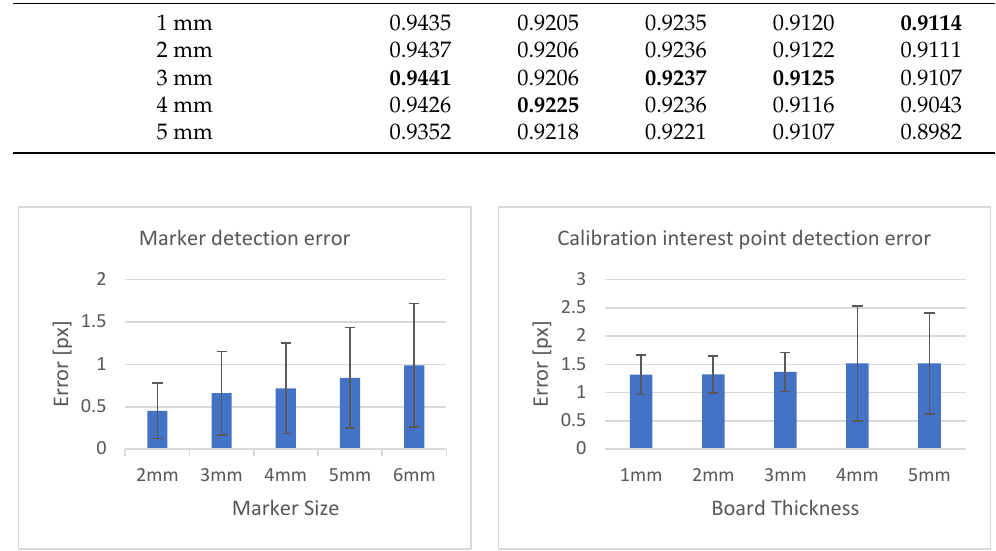
Figure 9. Marker detection error according to marker size ( left ). Calibration interest point detection error according to board thickness ( right ).